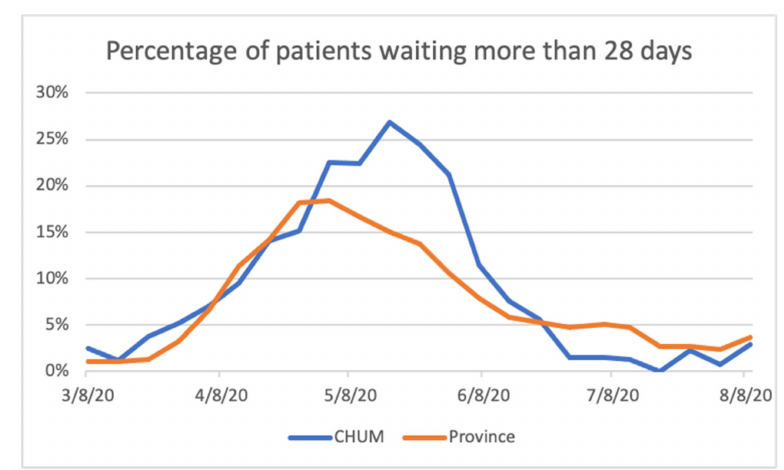
Figure 1. Percentage of patients waiting for radiotherapy for more than 28 days.